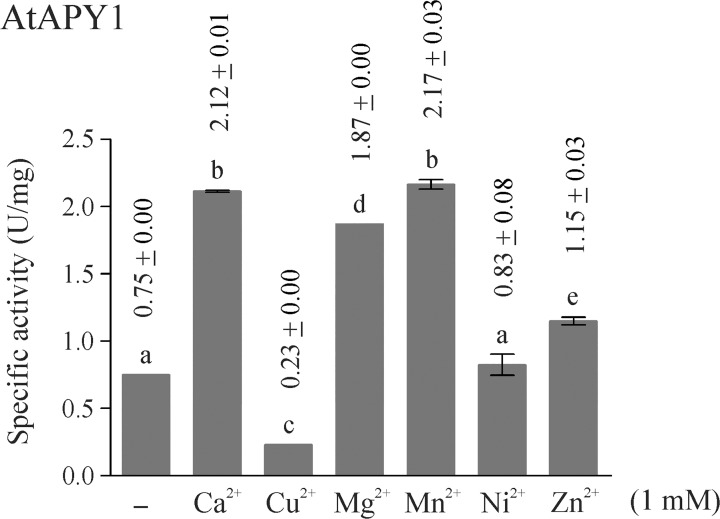
Influence of divalent metal ions on AtAPY1 activity.Enzyme activities were determined in the presence of 3 mM UDP using the discontinuous apyrase activity assay. The activity of AtAPY1 (1 U = 1 μmol Pi /min) was measured in the absence or presence of either 1 mM CaCl2, CuCl2, MgCl2, MnCl2, NiCl2 or ZnCl2. The control (-) shows the activity without the addition of any divalent ions. The means + SD of duplicates from one assay are shown. Different letters above the columns indicate mean values that are significantly different from one other (one-way ANOVA and Tukey test; p < 0.01). Data are representative of two activity assays.